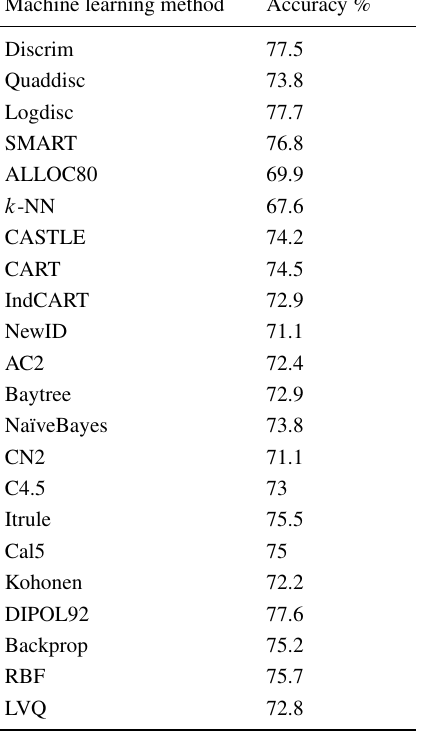
Table 2. The classification accuracy of different machine learning methods [10] on Pima Indian Diabetes